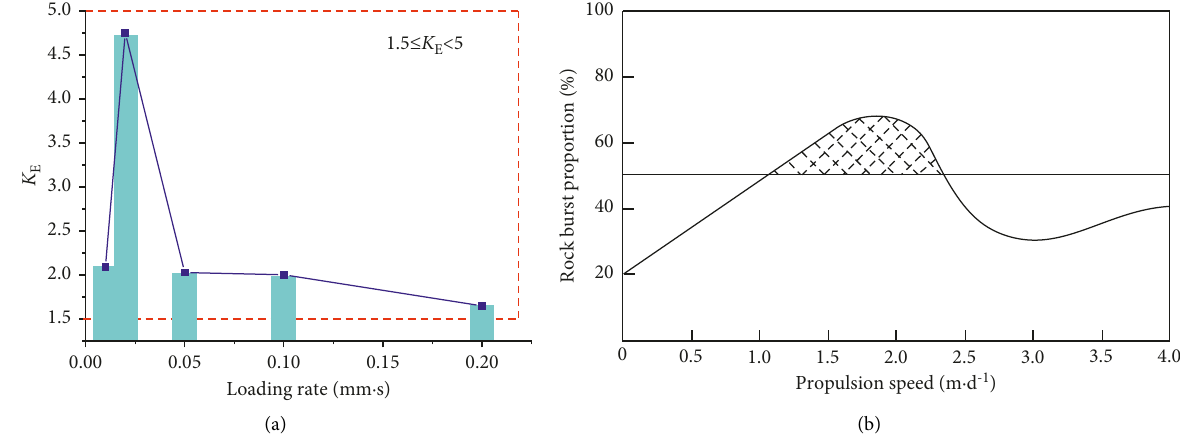
Figure 10: The Rock Burst Energy Index with different loading rates and rock burst proportion with propulsion